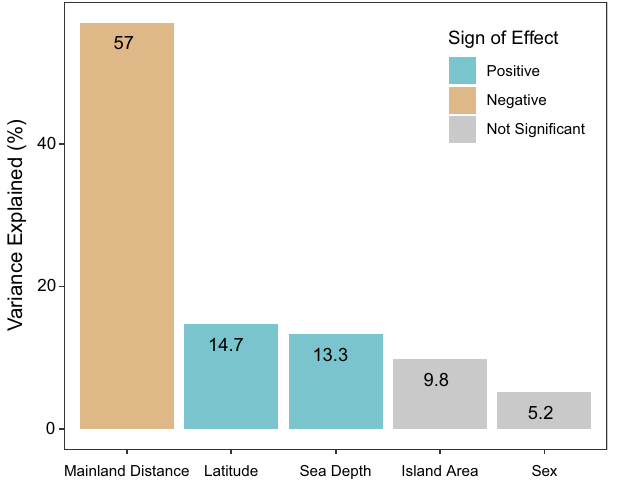
Figure 3. Percentage of variance explained by each variable included in a hierarchical partitioning analysis of body size on islands (Supplementary Table S3). Colors of bars correspond to the sign of the relationship between each variable and body size, as determined by a separate linear model and individual Pearson correlation tests. Variables identified as non-significant contributors to body size are indicated with gray